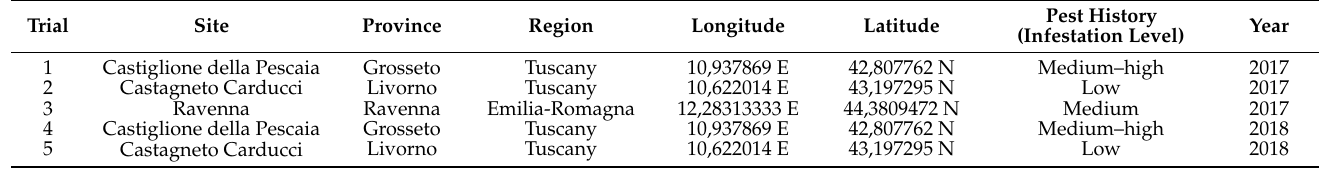
Table 1. Location of the Italian study sites, pest history and year of Lobesia botrana mating disruption trials.